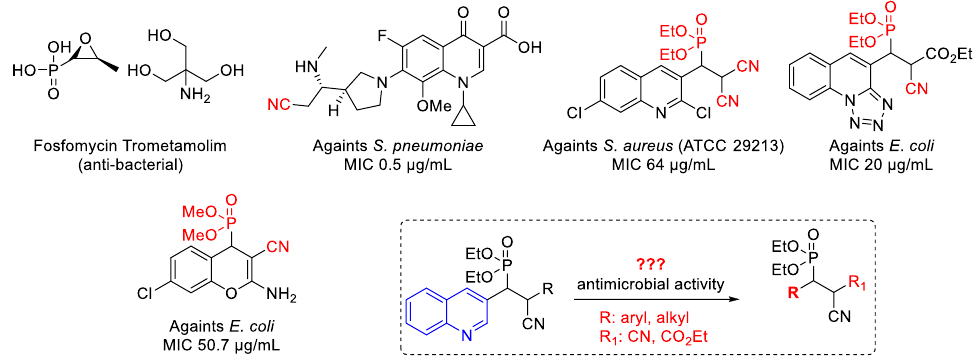
Figure 1. Biologically active antimicrobial nitrile-containing agents.